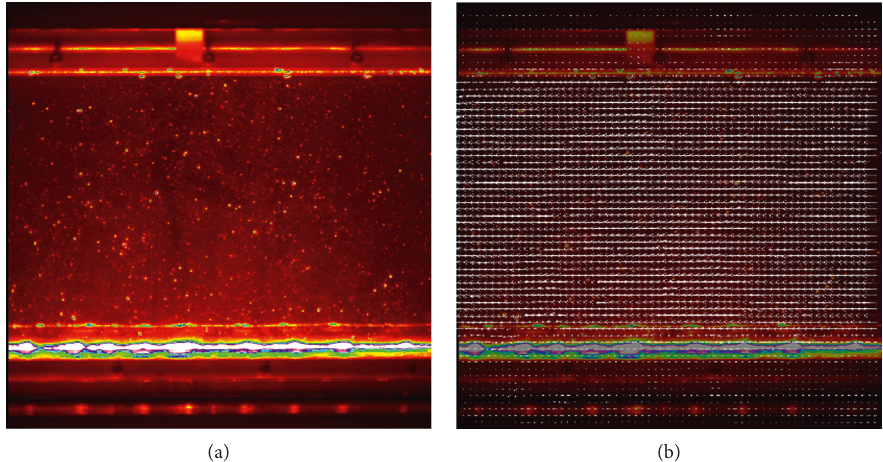
Figure 5: Generated oscillatory flow, (a) original record for oscillatory motion of T oscillatory motion of T